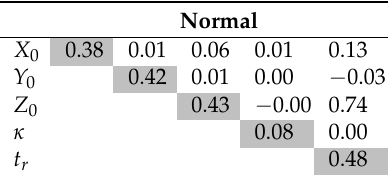
Table 5. Interpreted variance matrix Q ˆ computed from pseudorange observations of 8 satellites and P ˆ P image observations of 4 featutres with extended integration model, units are [m, m, m, degree, m].